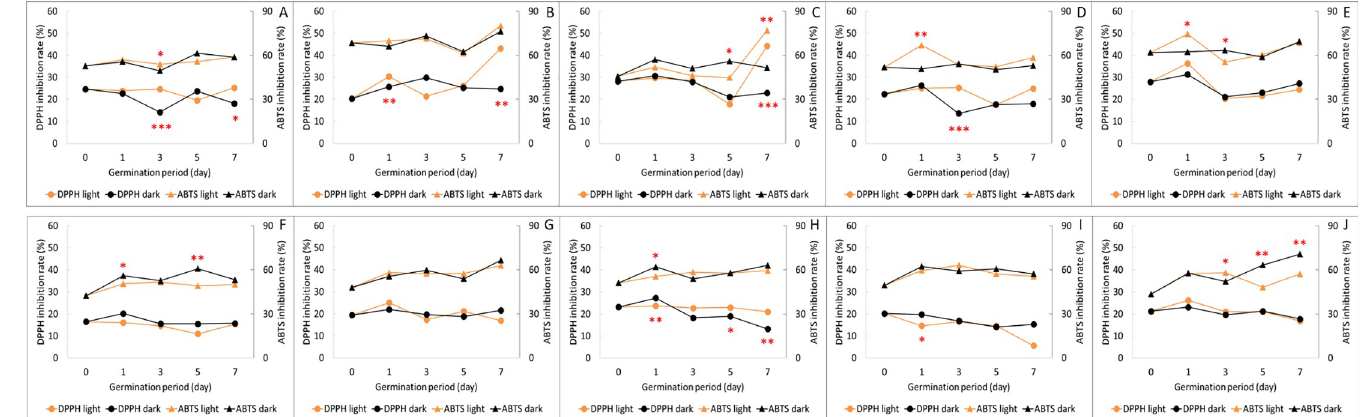
Fig 4. Changes in the total phenolic content, total flavonoid content, and antioxidant activities of small-seeded (A–E) and large-seeded (F–J) soybeans during germination under light and dark conditions. Values are the mean of three replicate determinations (n = 3) ± standard deviation. Statistical significance was shown by a t-test between the germination under light and dark conditions at the each time point ( ��� p < 0.001, �� p < 0.01, � p < 0.05). A, Socheongja; B, Youngwoljwinuni B/G; C, Dawonkong; D, Yaksunkong; E, Youngwoljwinuni B/Y; F, Cheongja3; G, GWS 148; H, Daewonkong; I, GWS 140; J, Taekwangkong. GAE, gallic acid equivalents; QE,